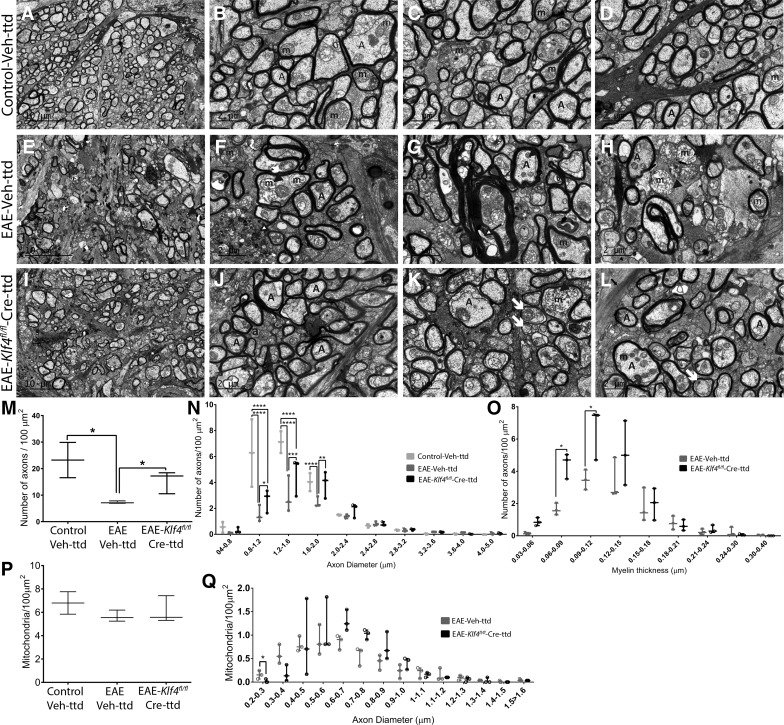
Axon counts, myelin, and mitochondria. Electron microscopy images of ON cross sections of (A–D) control-Veh-ttd mice shows healthy myelinated axons with normal mitochondria. E–H, EAE-Veh-ttd mice showed axonal loss and Wallerian-like degeneration (as shown by arrows in E, F), myelin degradation (as shown in G), and axons with either smaller or swollen mitochondria (shown with arrow heads in G, H). I–L, EAE-Klf4fl/fl-Cre-ttd mice ON with low caliber axons, axons with thinner myelin (showed with arrows in K), and normal as well as swollen mitochondria (arrowheads in K) were evident in EAE-Klf4fl/fl-Cre-ttd mice. M, Box and whisker plots compare axon counts among the three groups. N, Box and whisker plots compare the distribution of small to high diameter axons per 100-μm2 area in control-Veh-ttd, EAE-Veh-ttd, and EAE-Klf4fl/fl-Cre-ttd mice. O, Box and whisker plots compare the distribution of axons with low to high myelin thickness per 100-μm2 area in EAE-Veh-ttd versus EAE-Klf4fl/fl-Cre-ttd mice. P, Box and whisker plot compares the number of mitochondria per 100-μm2 area in control-Veh-ttd, EAE-Veh-ttd, and EAE-Klf4fl/fl-Cre-ttd mice ONs. Q, Box and whisker plot compares the mitochondrial number per 100-μm2 area with smaller to higher size in EAE-Veh-ttd versus EAE-Klf4fl/fl-Cre-ttd mice ONs. TEM imaging and axon counting was done by individual masked for the treatment groups. Statistical analyses were performed by one-way ANOVA followed by Tukey’s multiple comparison test for axon counts and mitochondrial counts. Two-way ANOVA followed by Tukey’s multiple comparison test was done for axon diameters. Two-way ANOVA followed by t test and statistical significance determined using the Holm–Sidak method, with α = 5% and computations assume that all rows are sample from populations with the same scatter (SD) was used for myelin thickness and mitochondrial size distribution analysis; p < 0.05 is considered to be statistically significant (n = 3 eyes/group, *p = 0.01–0.05, **p = 0.001–0.009, ***p = 0.0001–0.0009, ****p < 0.0001). A, axons; m, mitochondria. Scale bars: 10 μm (low-magnification images) and 2 μm (high-magnification images).Figure Contributions: Venu Talla and Rajeshwari Koilkonda acquired the images. Rajeshwari Koilkonda did the counting and diameters and myelin thickness measurements. Venu Talla and Rajeshwari Koilkonda analyzed the data. Venu Talla generated the figure.